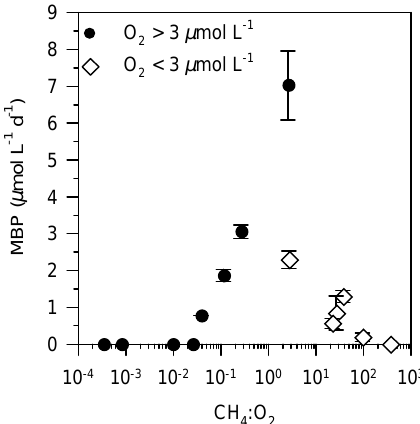
Figure 6. In Lake Kivu, relationship between the methanotrophic bacterial production rates (MBP, µmolCL − 1 d − 1 ) and the in situ CH 4 :O 2 molar ratio. Symbols represent mean MBP values, vertical error bars represent standard deviation of replicates. The CH 4 :O 2 ratio was calculated with an O 2 concentration value of 3µmolL − 1 when observed in situ values were below the detection limit of the sensor (3µmolL − 1 )